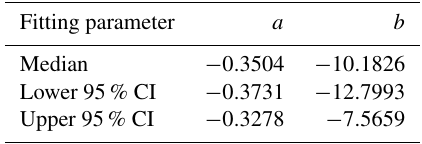
Table 1. List of parameters for the proposed INP concentration pa- rameterization (Eq. 3). Median and lower and upper 95% CI repre- sent the parameters in Eq. (3) for the median and lower and upper bound of 95% confidence interval, respectively, of the linear fit for the log-normal